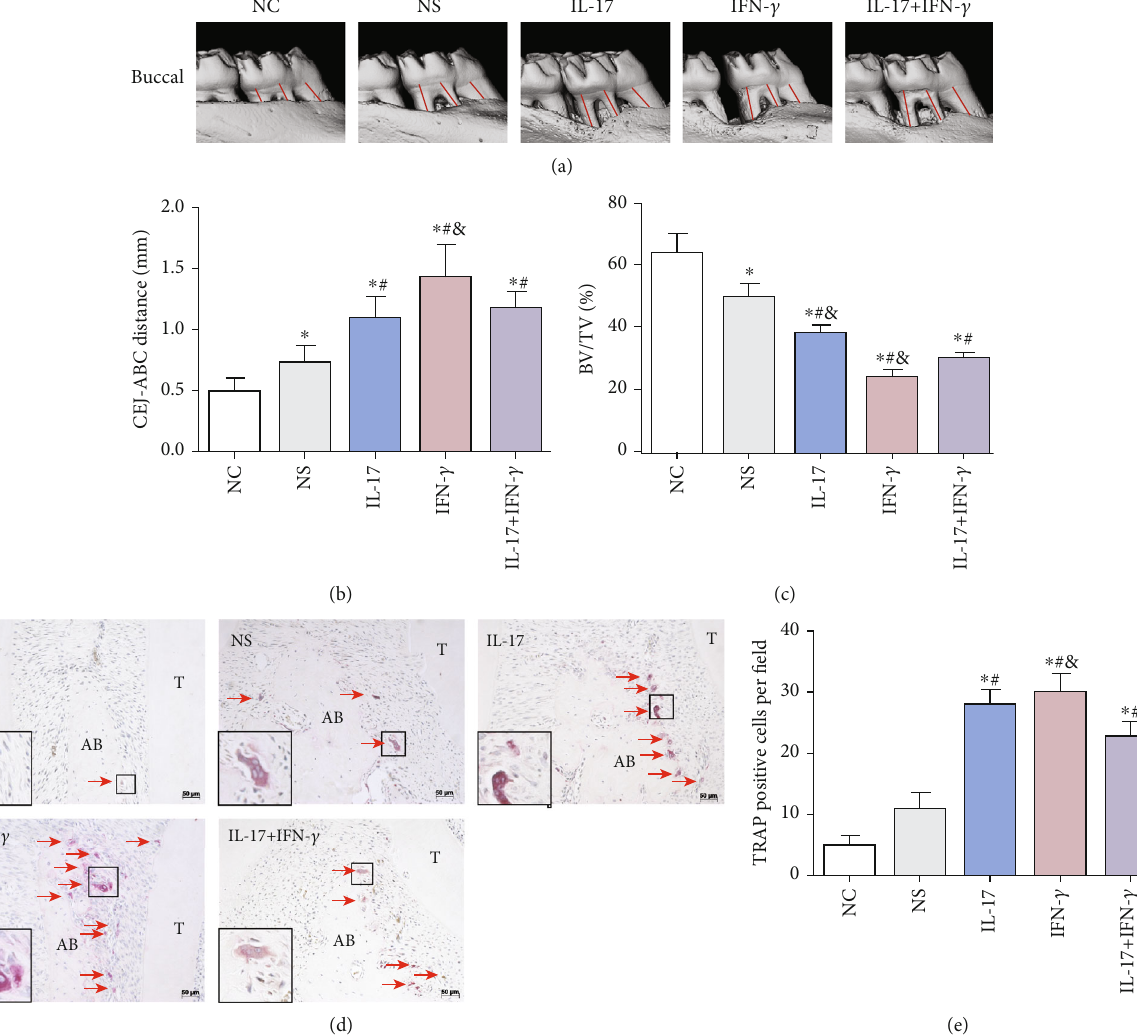
Figure 5: E ff ect of IL-17 (5 μ g/ml) or/and IFN- γ (1 μ g/ml) on alveolar bone loss and osteoclast di ff erentiation. (a) Reconstructed micro-CT images showed the buccal view of the fi rst maxillary molars. The distance from CEJ to ABC indicated bone loss, shown by the red lines. Quantitative analysis results of the (b) CEJ-ABC distance and (c) BV/TV are shown as mean ± standard deviation . (d) TRAP staining was used to evaluate the formation of osteoclasts (red arrows) for the NC, NS, IL-17, IFN- γ , and IL-17+IFN- γ groups ( scalebar = 50 μ m ). (e) Quantitative analysis was performed on the number of TRAP-positive multinucleated cells in the interradicular regions of the fi rst maxillary molars ( mean ± standard deviation , n = 5 ). ∗ p < 0 : 05 compared with the NC group, # p < 0 : 05 compared with the NS group, and & p < 0 : 05 compared with the IL-17+IFN- γ group. ABC: alveolar bone crest; CEJ: cemento-enamel junction; BV: bone volume; TV: tissue volume; T: tooth; AB: alveolar